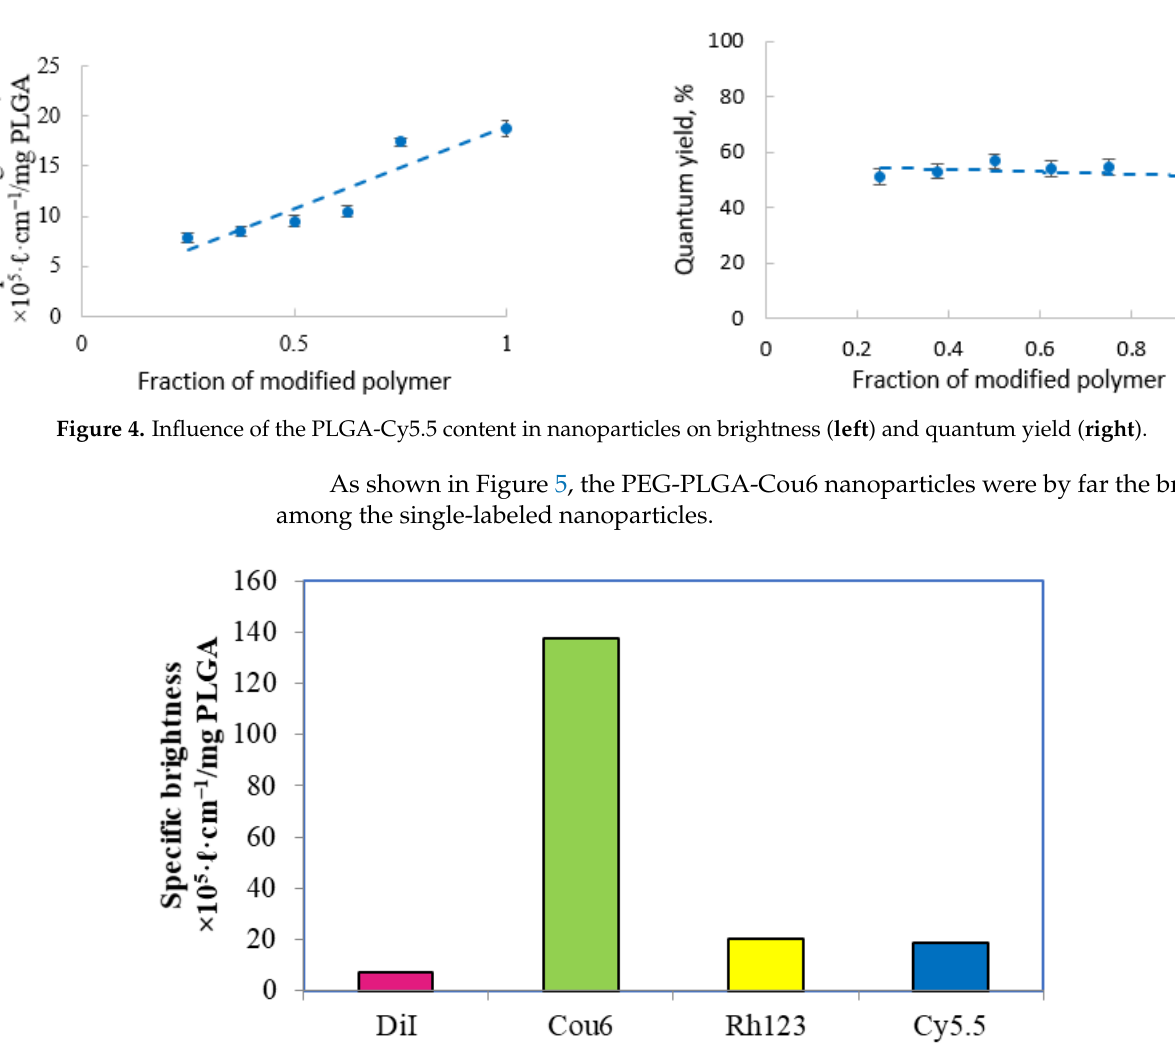
Figure 5. Maximal specific brightness values for the PLGA nanoparticles with a single label.